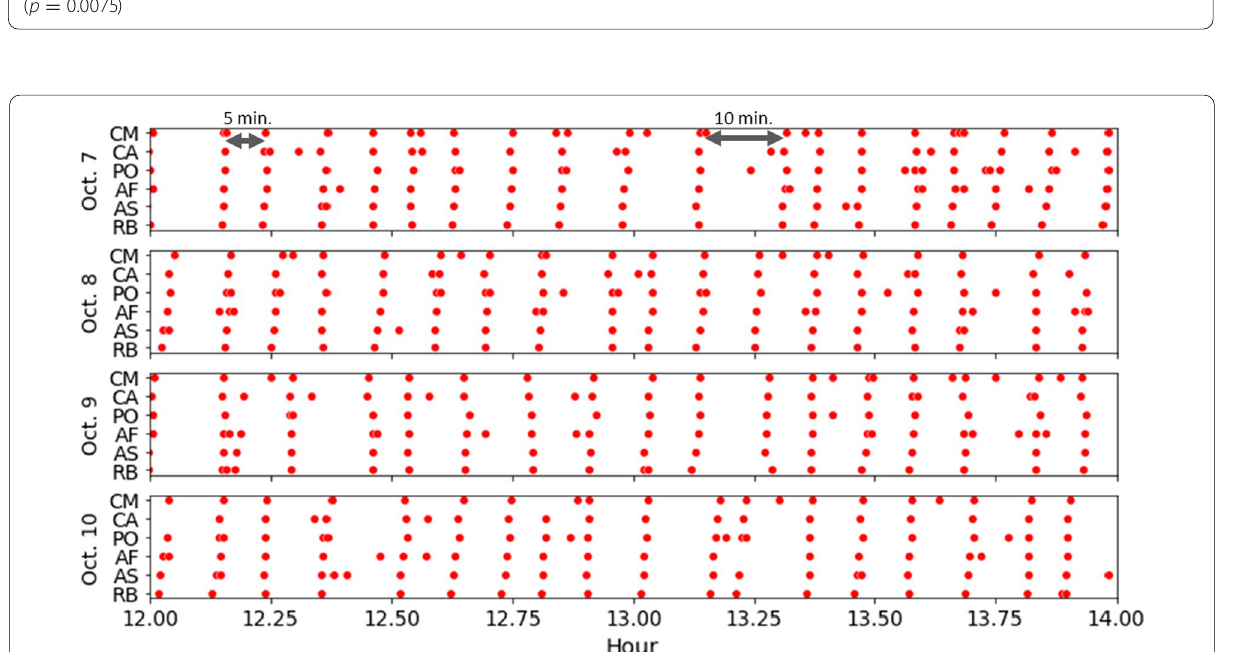
Fig. 16 Aligned passenger volume peaks for the last six stations of the blue line for four different dates over the same time of the day, showing evidence of inconsistencies in actual train dispatch